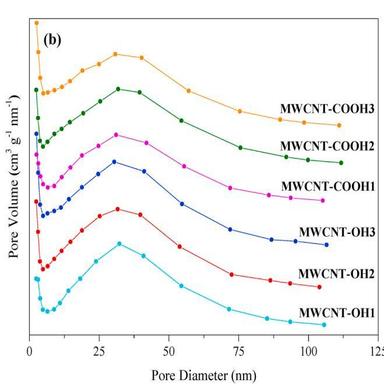
MWCNTs modified via green synthesis: (a) N2 adsorption-desorption isotherms and (b) pore size distribution. (For interpretation of the references to color in this figure legend, the reader is referred to the Web version of this article.)